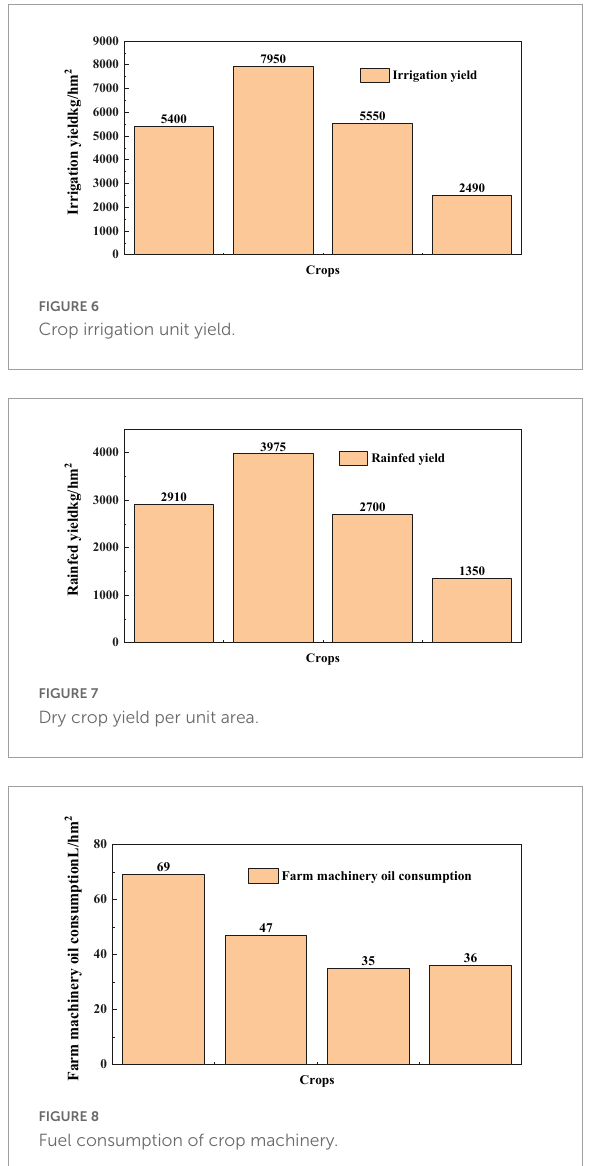
FIGURE8 Fuel consumption of crop machinery.